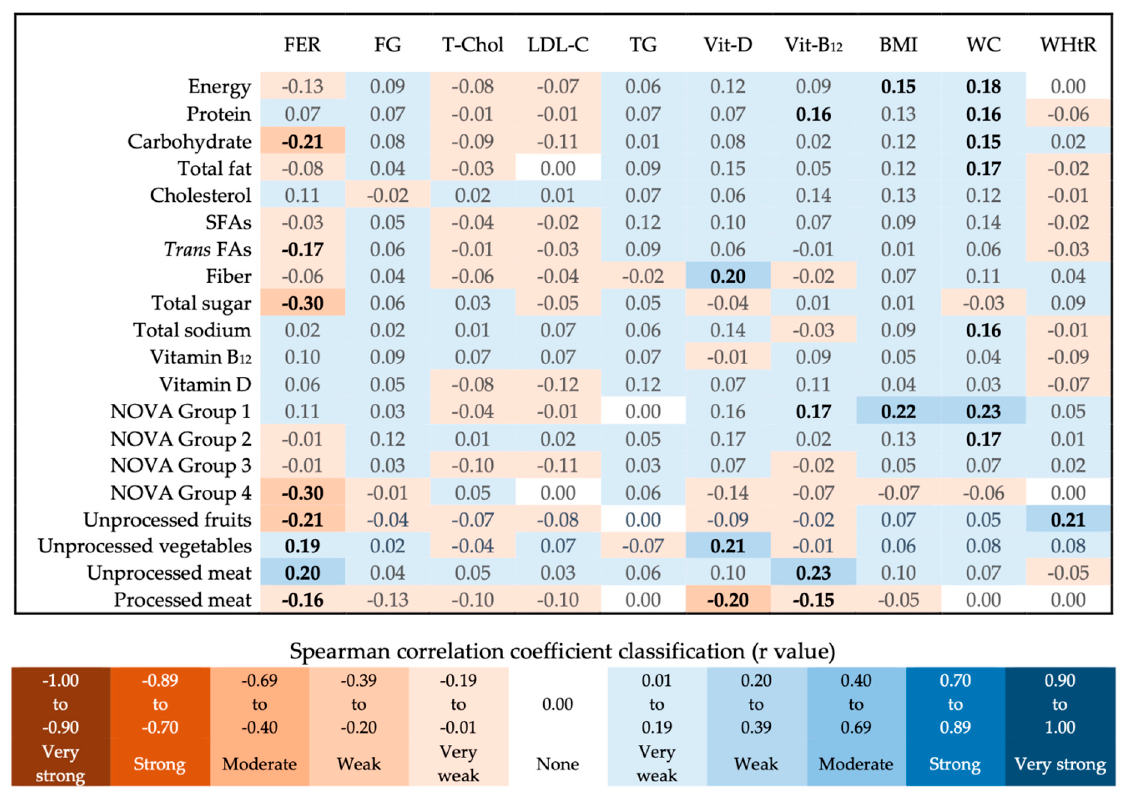
Figure 4. Food consumption or nutrient intake and nutritional status correlation heatmap. Statistical test: Spearman correlation. The r values in bold indicate statistically significant differences ( p < 0.05). FER (ferritin), FG (fasting glucose), T-Chol (total cholesterol), LDL-C (LDL cholesterol), TG (triglycerides), Vit-D (Vitamin D), Vit-B 12 (Vitamin B 12 ), BMI (Body Mass Index), WC (Waist Circumference), WHtR (Waist-to-Height Ratio), SFAs (Saturated Fatty Acids), Trans FAs ( Trans Fatty Acids), NOVA Group 1 (unprocessed foods), NOVA Group 2 (processed culinary ingredients), NOVA Group 3 (processed foods), NOVA Group 4 (ultra-processed foods). Measurement units: fiber (g), cholesterol and total sodium (mg), vitamins B 12 and D (µg), and the others (calories).